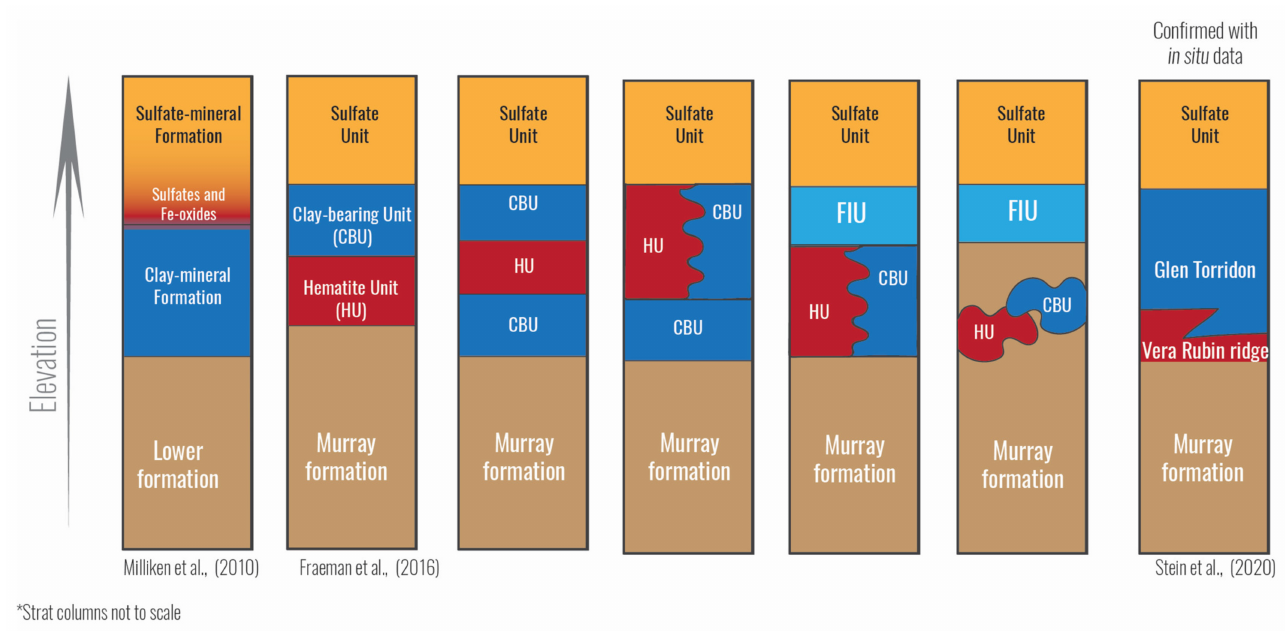
Figure 7. Depiction of refinement of hypotheses over the course of Curiosity’s mission [18,28,112] for the stratigraphic relationship between the clay-bearing (Glen Torridon) and hematite-bearing (Vera Rubin ridge) geomorphic units. The relationship between the two was not resolved until in situ data were available, and understanding this relationship was critical for understanding the importance of diagenesis in the formation of the secondary phases observable from orbit [111]. Figure after